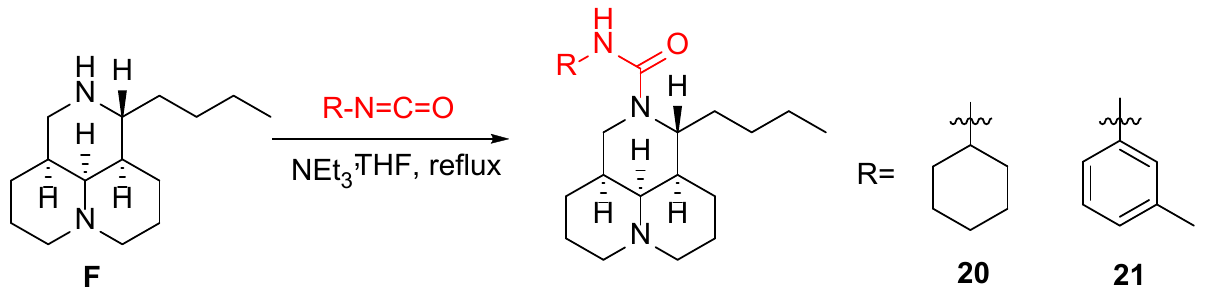
Scheme 3. The synthetic route for matrine derivatives 20 and 21 .